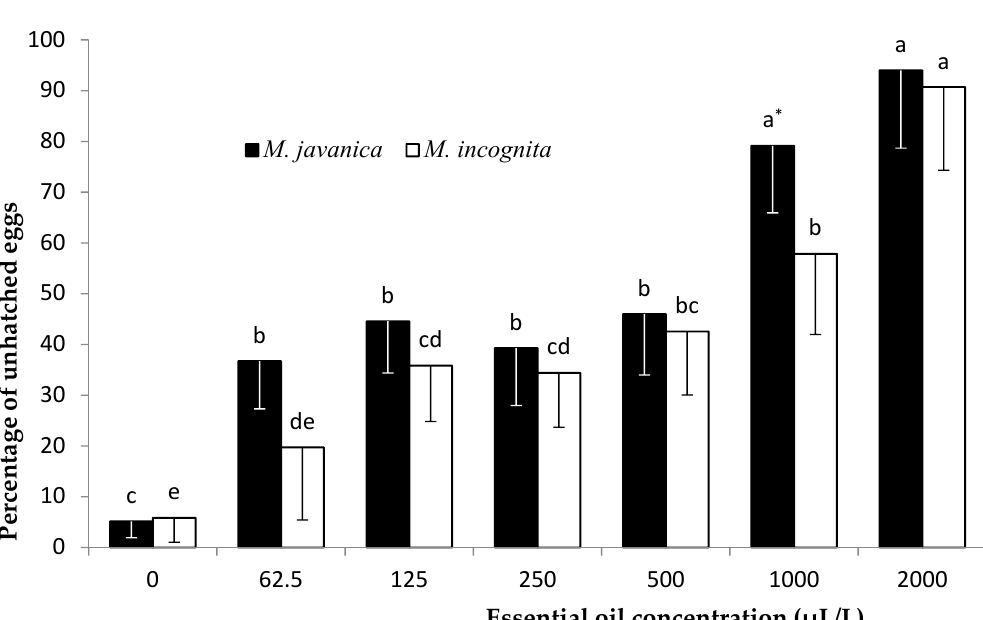
Plants 2021 , 10 , x FOR PEER REVIEW Figure 5. Effect of Cuminum cyminum seed essential oil on hatching of M. incognita and M. javanica J2s after immersion in test solutions at concentrations of 0, 7.8, 15.6, 31.2, 62.5, 125, 250, and 500 μ L/L for 35 days. * Bars with the same color followed by the same letter are not significantly different according to Tukey’s HSD test at p < 0.05.